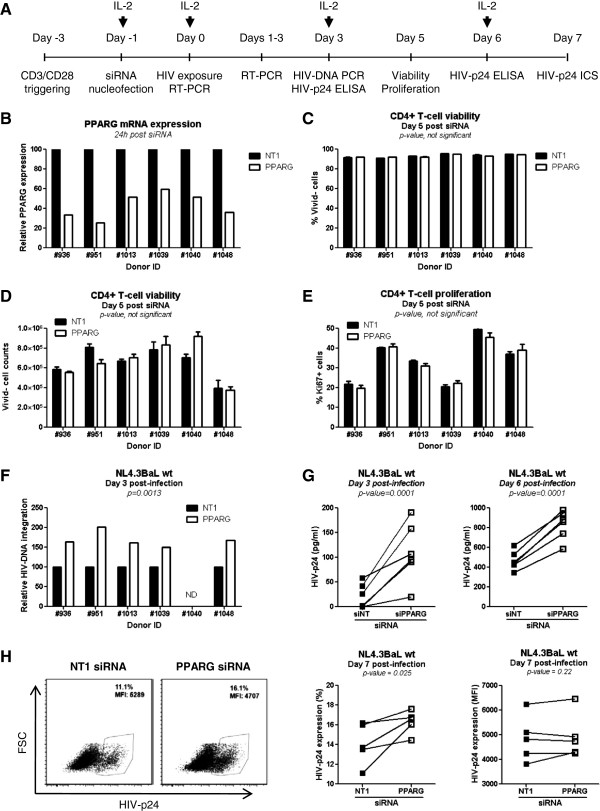
PPARγ RNA interference increases HIV replication in memory CD4+ T cells. Memory CD4+ T-cells were isolated from thawed PBMC rested overnight by negative selection using magnetic beads. (A) Cells were stimulated via CD3/CD28 for 2 days, nucleofected with PPARγ or non-targeting (NT1) siRNA, and then cultured for an additional 24 h at 2x106 cells/ml in the presence of IL-2. (B) RNA silencing efficiency was assessed by RT-PCR 24 h post-nucleofection (n = 6). (C-E) The effect of NT1 and PPARγ siRNA on cell viability and proliferation was assessed by flow cytometry at day 6 post-nucleofection (n = 6). Cell viability was monitored using the viability dye Vivid (C), cell counts were determined using FlowCounts fluorospheres (D), and cell proliferation was measured upon intracellular staining with Ki67 Abs (E). Cells were exposed to replication competent NL4.3BAL wt strain (10 ng HIV-p24/106 cells) for 3 h at 37°C. Unbound virus was removed by extensive washing, and cells were maintained in culture in the presence of IL-2 up to 7 days post-infection. (F) Integrated HIV-DNA levels were quantified by real-time PCR in cells harvested at day 3 post-infection (n = 5). (G) Levels of HIV-p24 in cell supernatants were quantified by ELISA at days 3 and 6 post-infection (n = 6). (H) At day 7 post-infection, cells were harvested and the frequency of infected cells was analyzed by flow cytometry upon intracellular staining with HIV-p24 Abs. Shown is the frequency of HIV-p24+ cells (% and MFI, mean fluorescence intensity) upon nucleofection with PPARγ vs. NT1 siRNA in one representative subject (left panels) and statistical analysis in n = 5 different subjects (right panels). Paired t-Test values are indicated on the graphs.